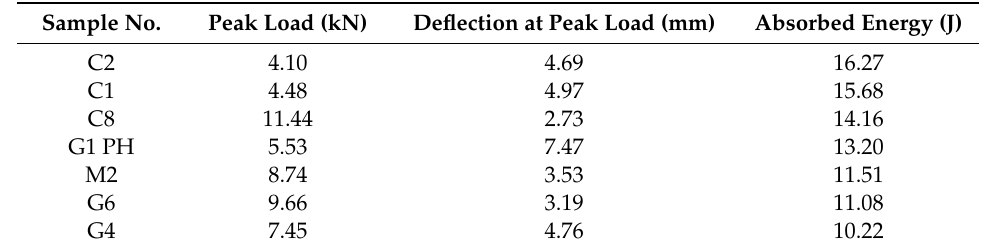
Table 10. Summary of the experimental results for high-performing cases with high absorbed energies. Sample No.